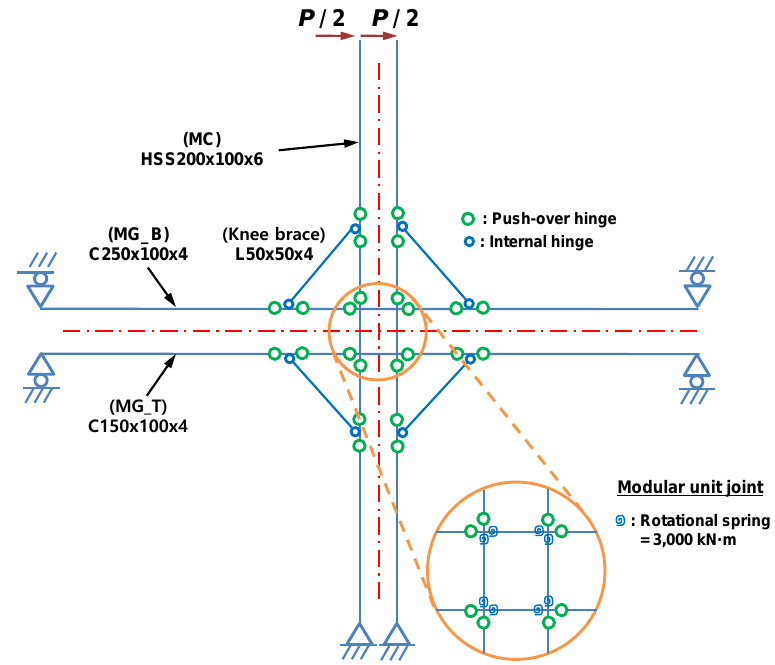
Figure 22. Push-over analysis model of IC_OB_B specimen. (unit: mm).